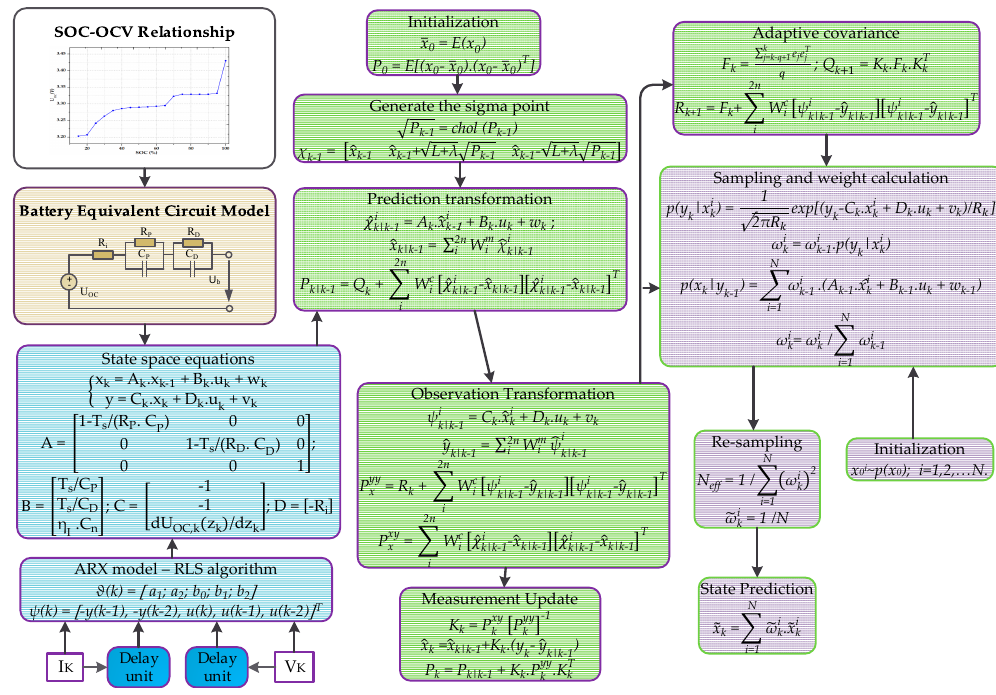
Figure 3. Flowchart of the proposed estimation algorithm.